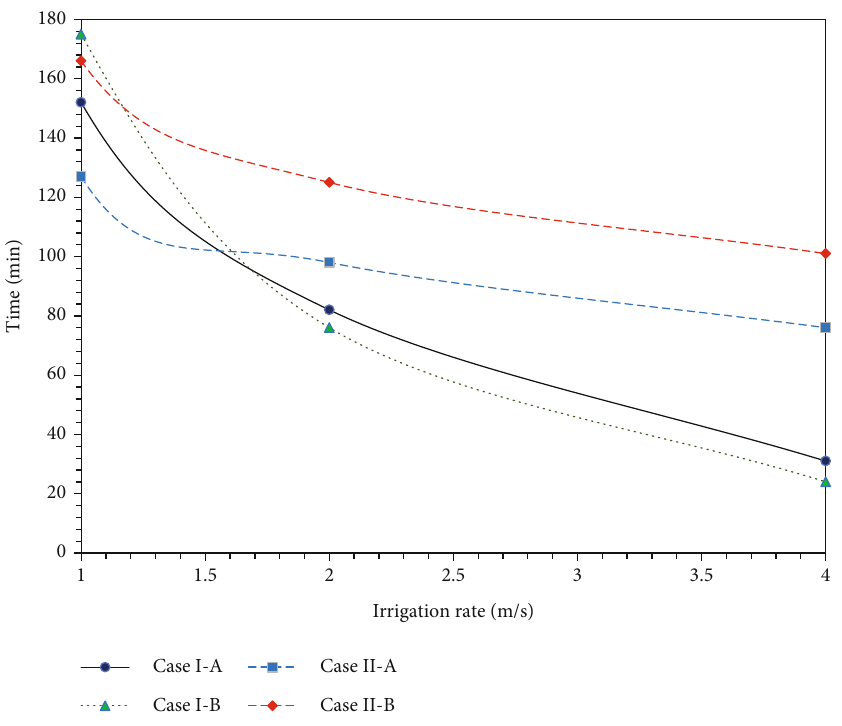
Figure 12: Time required to attain full saturation vs. irrigation